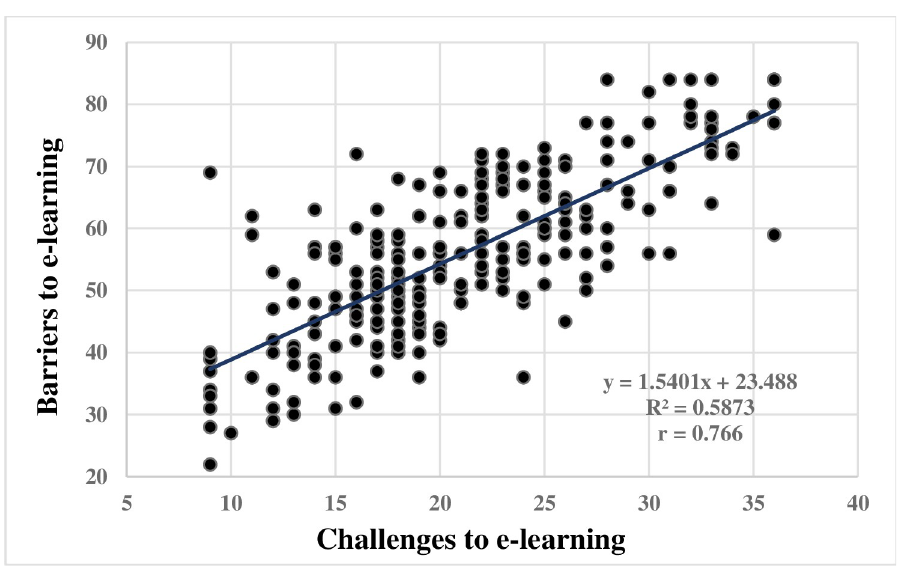
Fig 1. Pearson’s correlation coefficient between challenges and barriers, total